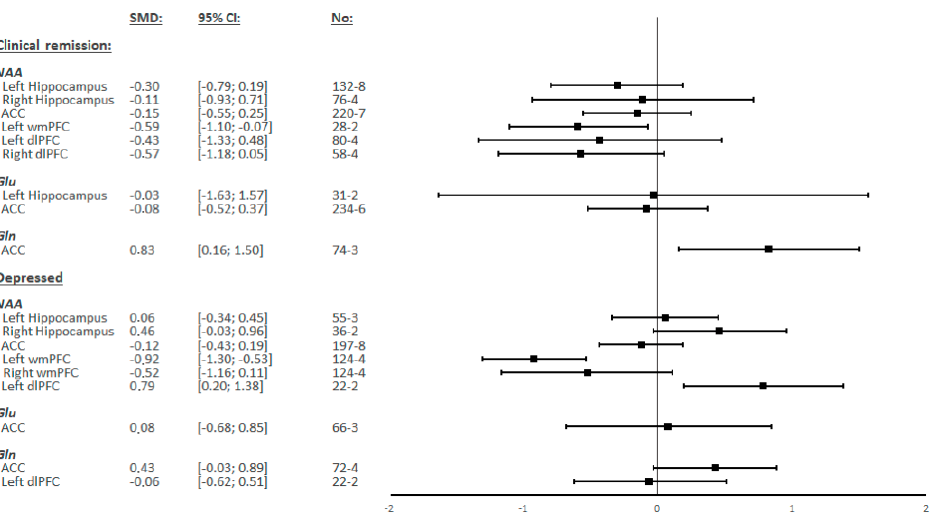
Figure 2. Summary of Standardized Mean Differences (SMDs) and their confidence intervals (95% CI) for each metabolite in each of the different regions by the mood status of bipolar patients.